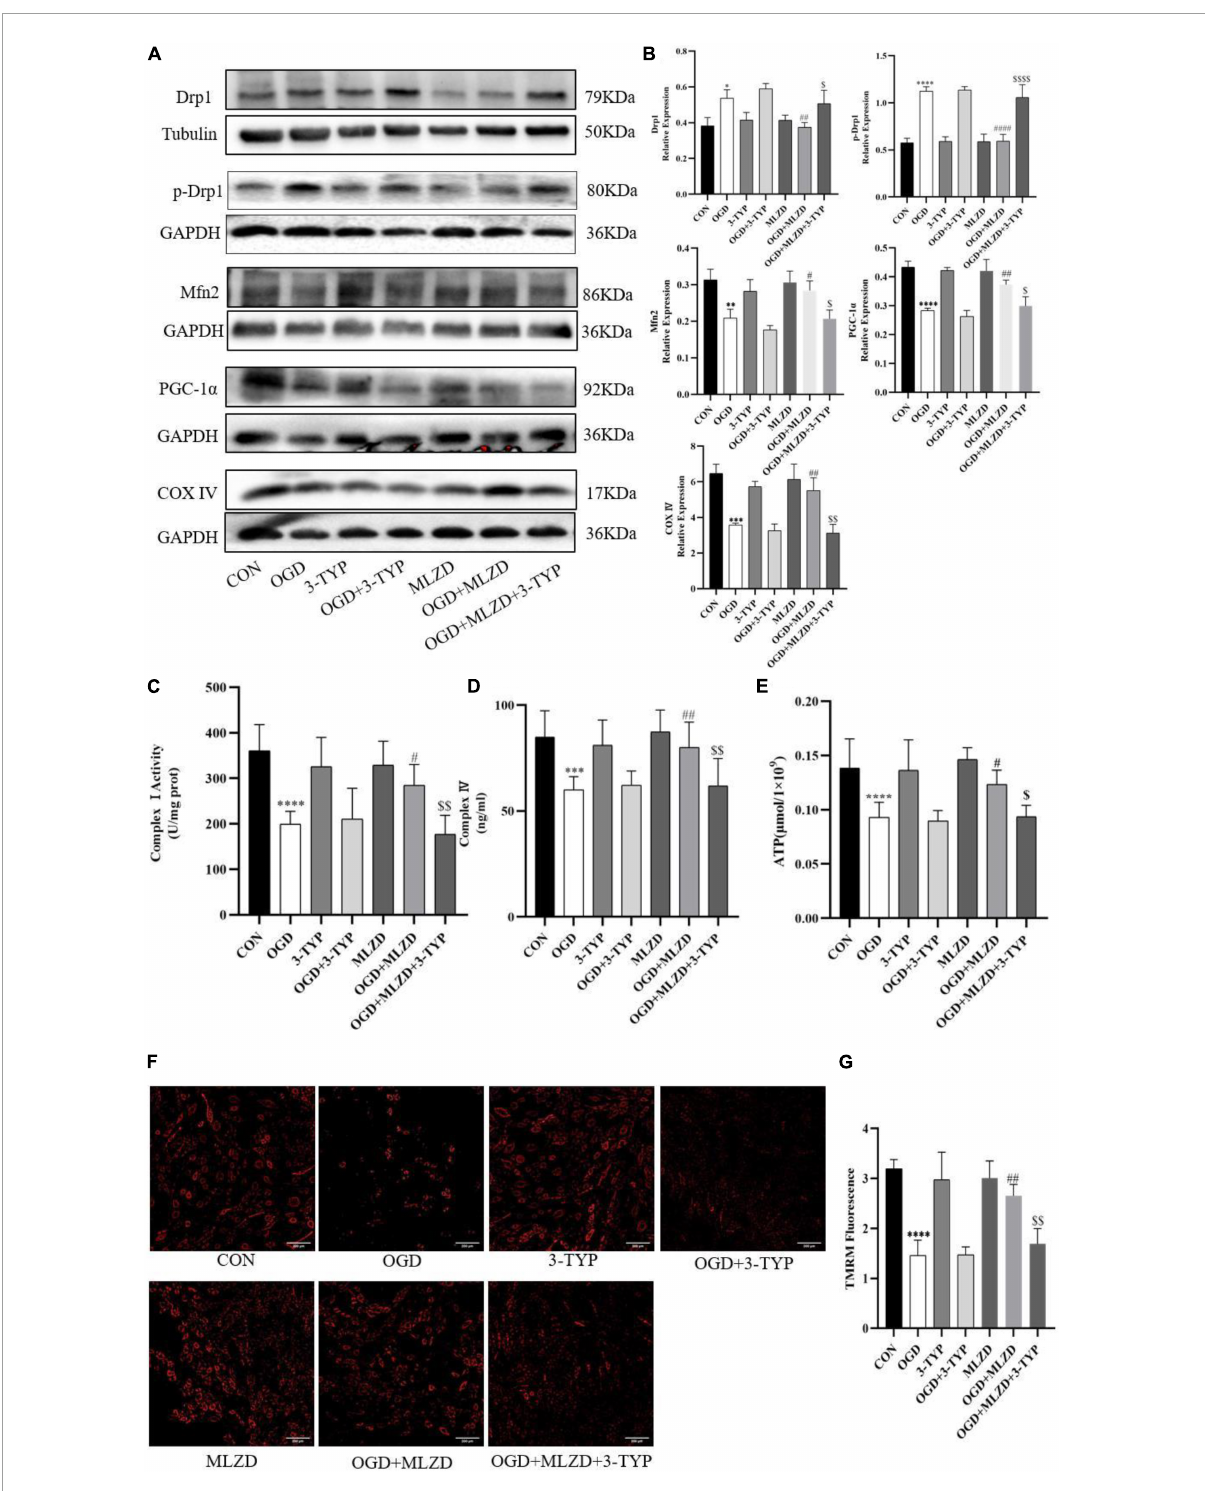
FIGURE9 3-TYP reversed the regulation of mitochondria by Modified Linggui Zhugan Decoction (MLZD). (A,B) Detection of Drp1, p-Drp1, Mfn2, PGC-1 α , and COX IV in cardiomyocytes by western blotting. The widths of the images have been compressed at a ratio of 1:0.8. (C,D) Detection of mitochondrial electron transport chain complex I and IV in cardiomyocytes. n = 8 per group. (E) Determination of ATP content in cardiomyocytes. n = 8 per group. (F,G) TMRM staining for assessing mitochondrial membrane potential, n = 3 per group, scale bar = 200 µ m. Data are represented as mean ± standard deviation ( x ± s); ∗ P < 0.05, ∗∗ P < 0.01, ∗∗∗ P < 0.001, ∗∗∗∗ P < 0.0001 vs. CON; # P < 0.5, ## P < 0.01, #### P < 0.0001 vs. OGD; $ P < 0.05, $$ P < 0.01, $$$$ P < 0.0001 vs. OGD +